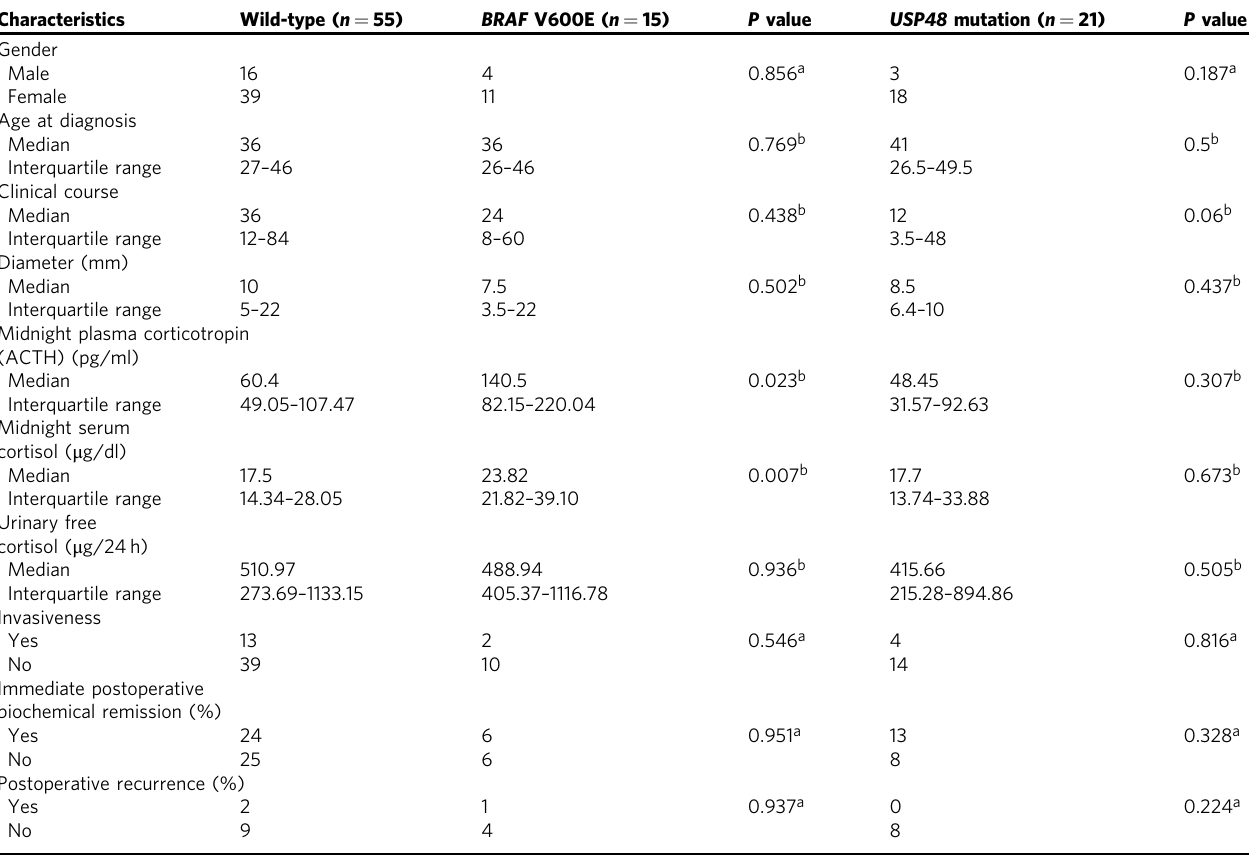
Table 1 Clinical and phenotypic features of patients with Cushing ’ s disease